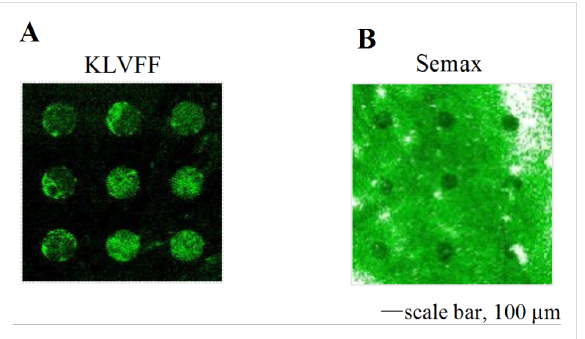
Figure 3: (A) KLVFF and (B) Semax spot arrays on an epoxysilane- coated HES after amyloid incubation. The fluorescence measure- ments were performed by operating at an optimized condition for laser power and gain (60% laser power and gain for KLVFF and 100% laser power and gain for